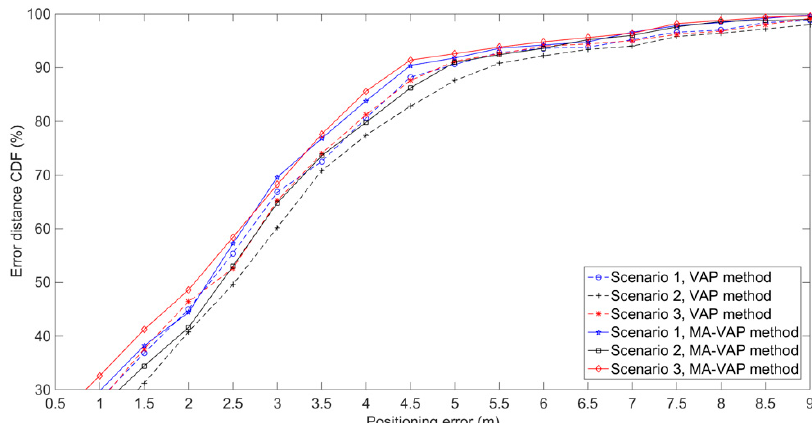
Figure 13. Positioning results of the VAP method and MA-VAP method for three di ff erent scenarios. Table 2. Positioning errors of the VAP method and the MA-VAP method at the 90% CDF for three different scenarios.